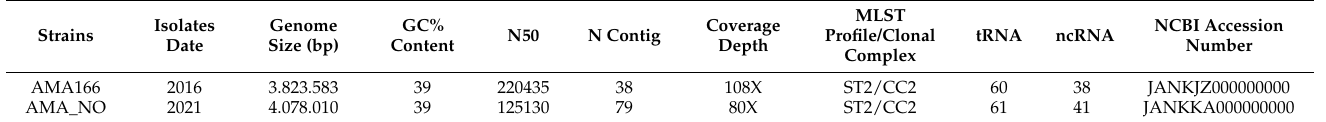
Table 1. Genome features of A. baumannii AMA_NO and